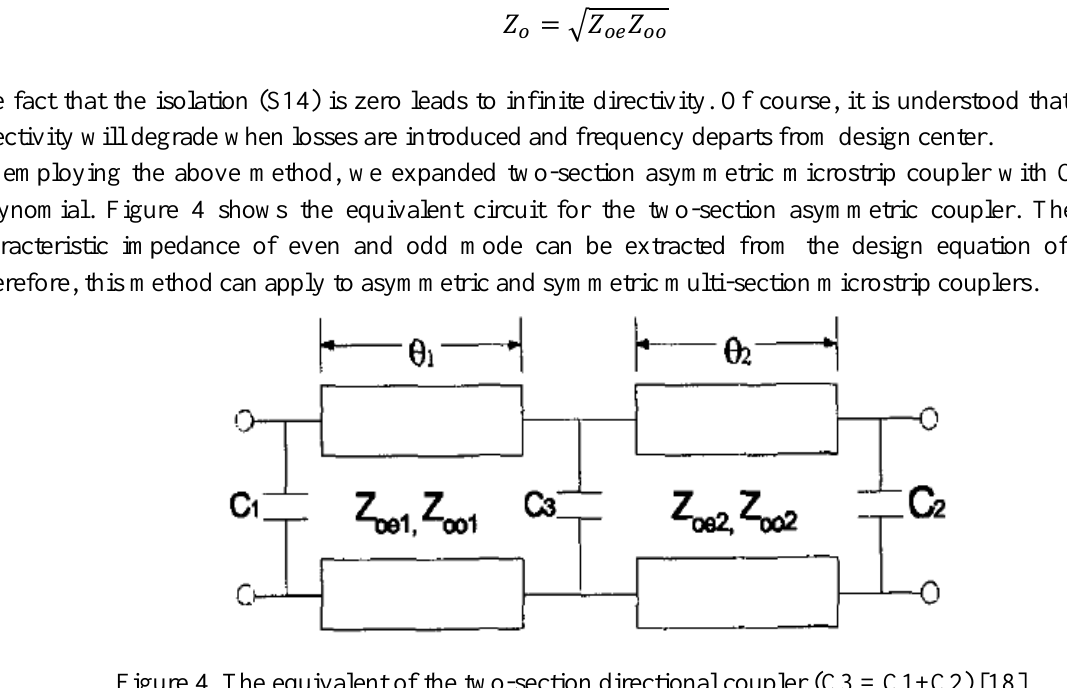
Figure 4. The equivalent of the two-section directional coupler (C3 = C1+C2) [18]